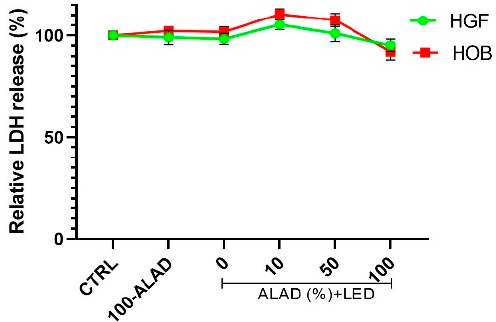
Figure 1. Cytotoxicity assay. HGF and HOB were subjected to ALAD-PDT treatment, and LDH release was measured at 24 h. The data are expressed as percentages with respect to the control (CTRL).